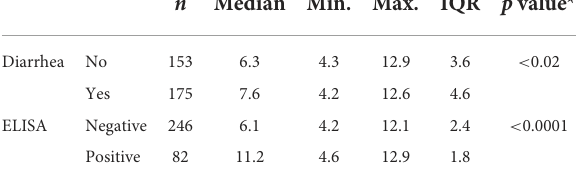
TABLE 1 Log10 viral load of RVA determined by RT-qPCR in calves with and without diarrhea, and in calves that tested positive or negative for RVA antigen by capture ELISA.